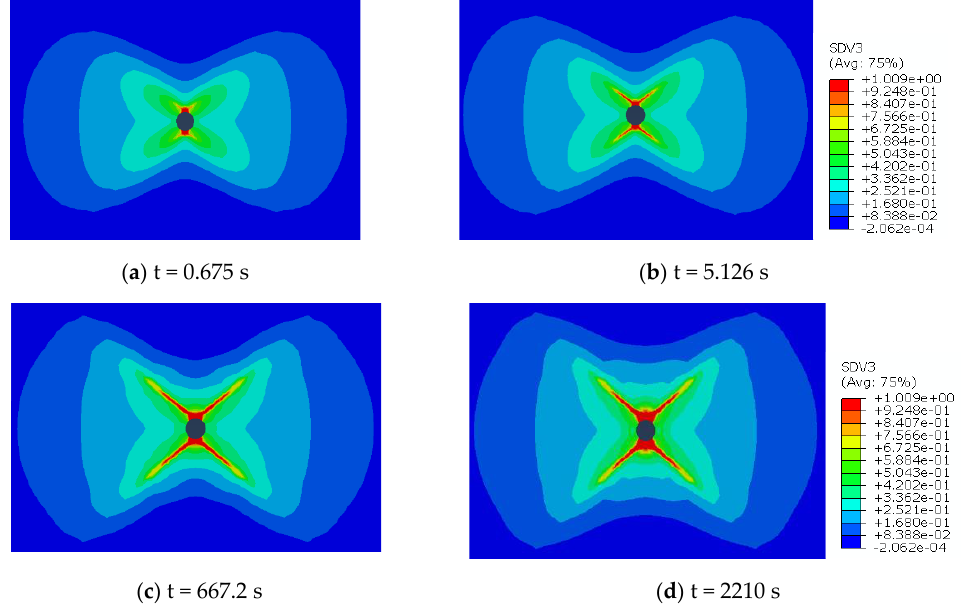
Figure 4. Evolution of damage region (SVD3 represents disturbance damage factor).